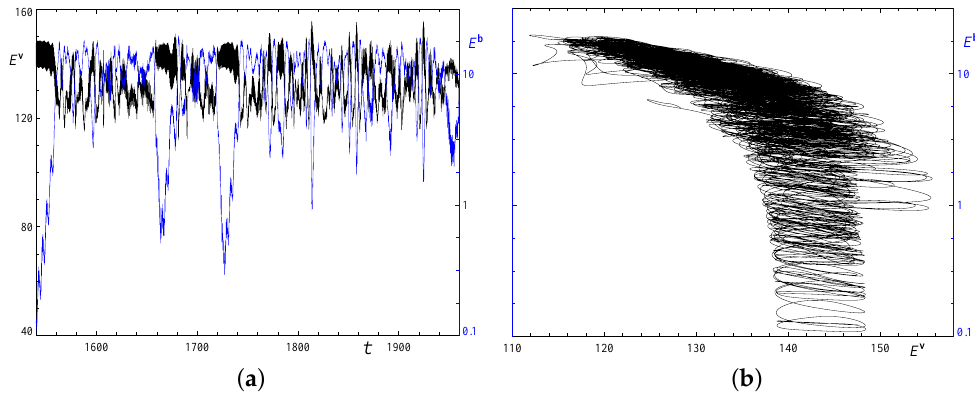
Figure 10. Temporal behaviour of the kinetic (left vertical axis, black line) and magnetic (right vertical axis, blue line) energies in the double-period run 2 x 1.2 for 1540 ≤ t ≤ 1960, phase S (a). Evolution of the magnetic energy versus kinetic energy in this run in the same time interval